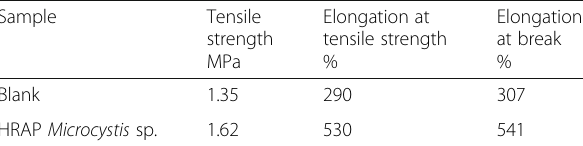
Table 1 Mechanical properties of bioplastic produced from HRAP microalgal biomass Sample Tensile Elongation at strength tensile